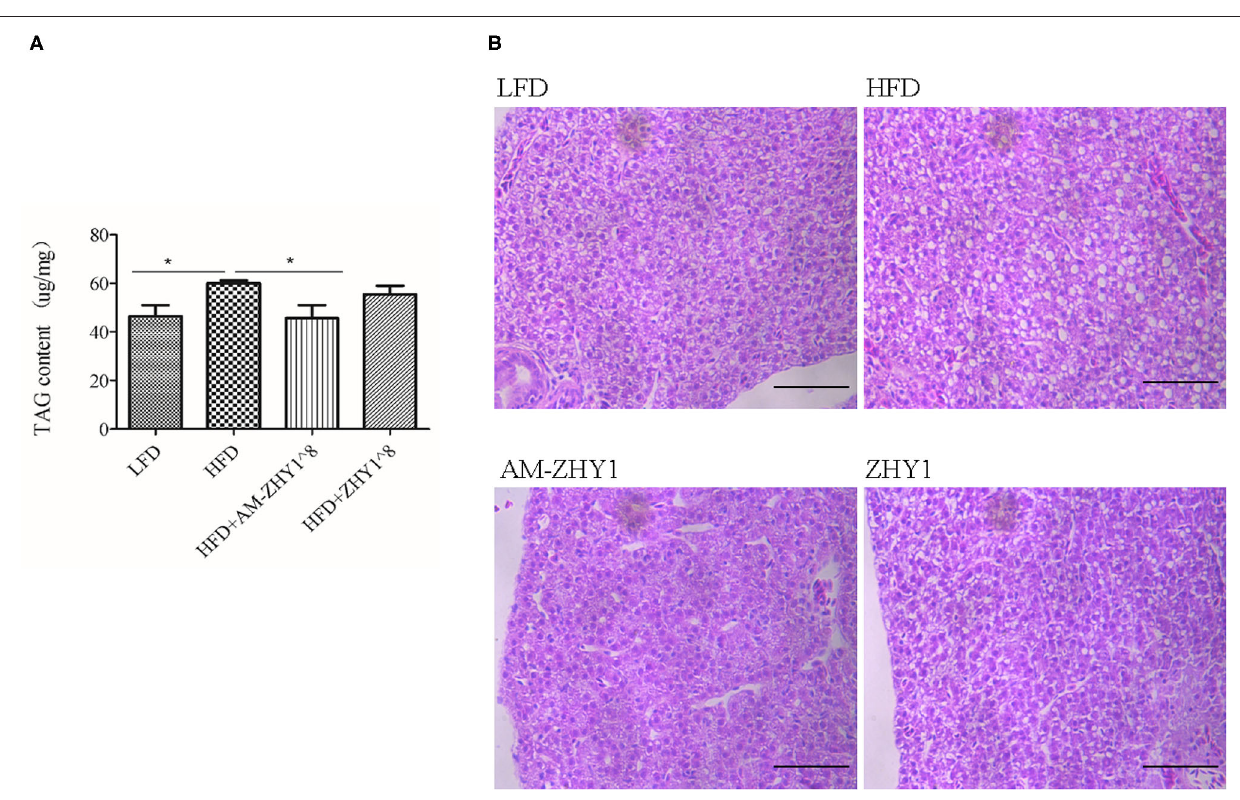
The addition of AM-ZHY1 and ZHY1 to the high-fat diet both inhibited the expression of the ATGL of zebrafish ( p < 0.05; p = 0.07). Taken together, these results demonstrated that the supplement AM-ZHY1 with the high-fat diet led to the improvement of hepatic steatosis. Furthermore, this regulatory effect of AM-ZHY1 on liver lipid accumulation was through inhibiting lipid synthesis and absorption, rather than promoting